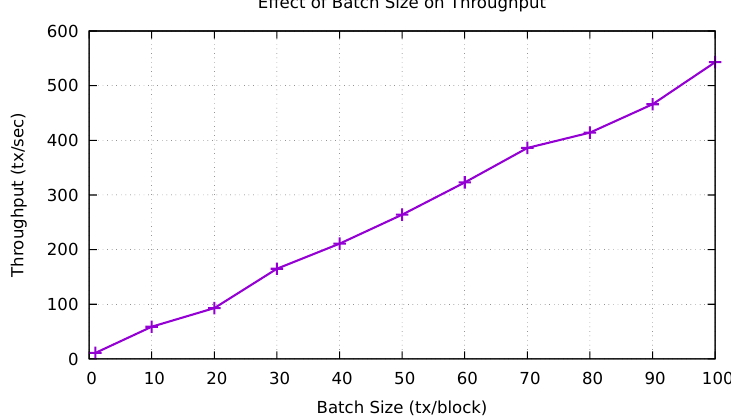
Figure 9. Effect of batch size to throughput